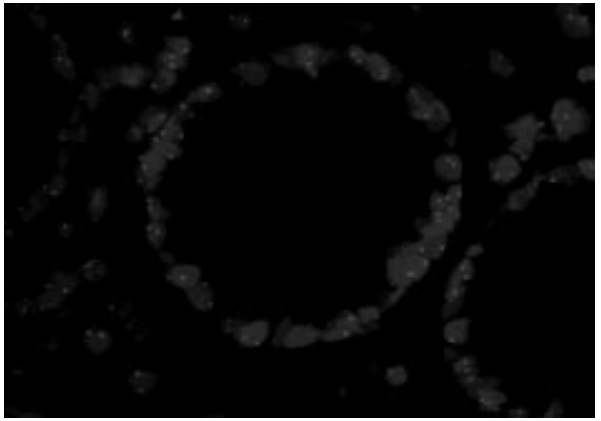
Fig. 1. Typical example of a two-dimensional image of 3D fixed, 4 (cid:22) m thick colon tissue section with FISH signals of chromosome 7 centromere. The nuclei were counterstained with